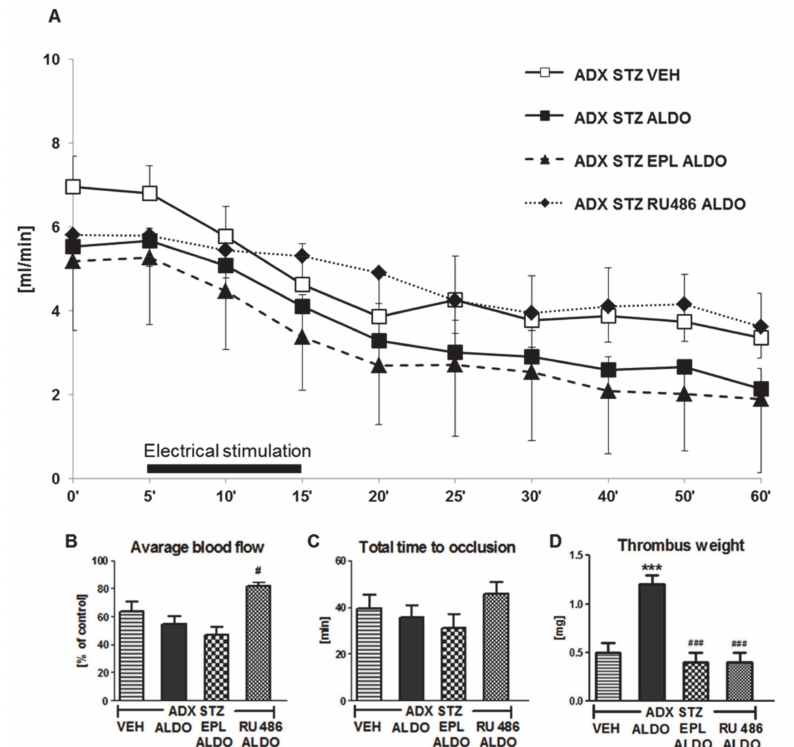
Figure 3. The role of mineralocorticoid and glucocorticoid receptors in the prothrombotic effect of aldosterone. ( A ) The mean carotid blood flow during the entire experiment; ( B ) average blood flow; ( C ) total time to occlusion; ( D ) thrombus weight; ADX STZ VEH—adrenalectomized streptozotocin-induced diabetic rats, infused with vehicle; ADX STZ ALDO—adrenalectomized streptozotocin-induced diabetic rats, infused with aldosterone; ADX STZ EPL ALDO—adrenalectomized streptozotocin-induced diabetic rats, administered with eplerenone and aldosterone; ADX STZ RU486 ALDO—adrenalectomized streptozotocin-induced diabetic rats, administered with RU486 and aldosterone. Data are presented as mean ± SEM; *** p < 0.001 vs. VEH; # p < 0.05, ### p < 0.001 vs. ALDO, n =